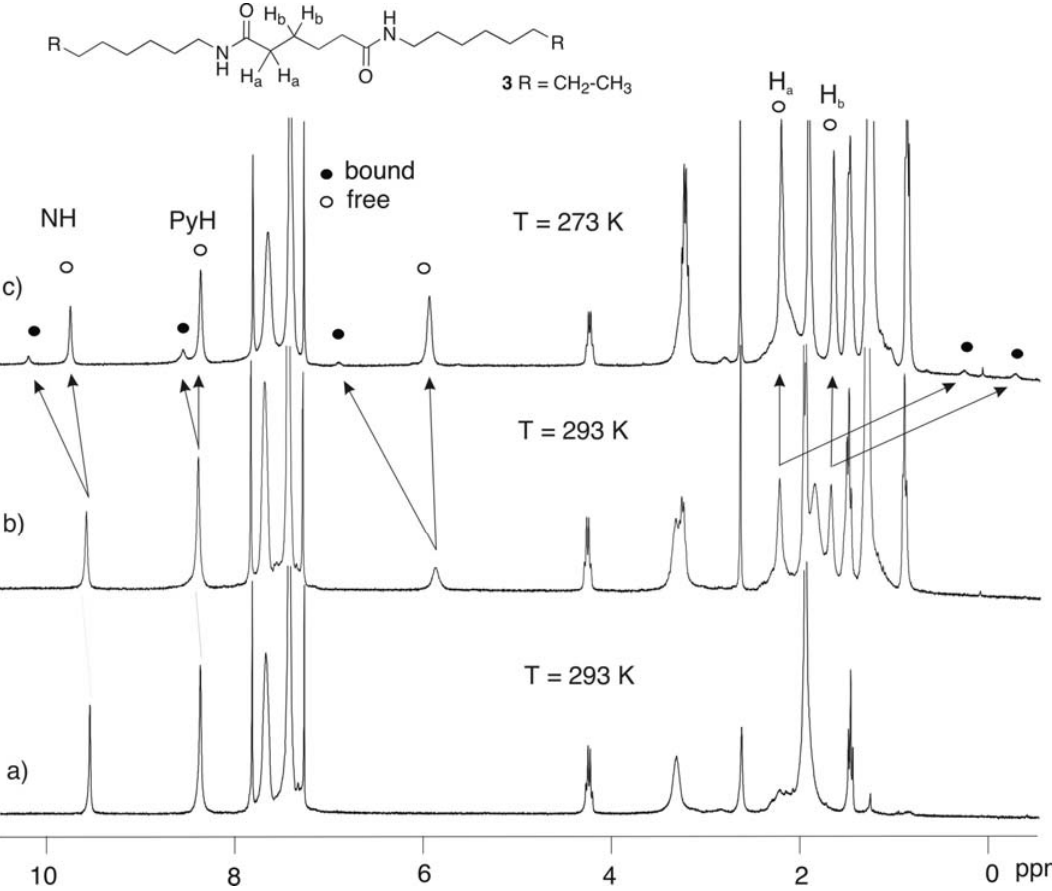
Figure 1. 1 H-NMR spectra (300 MHz) in CDCl mM) at 293 K, c) 2 (4mM) + 3 (16 mM) at 273